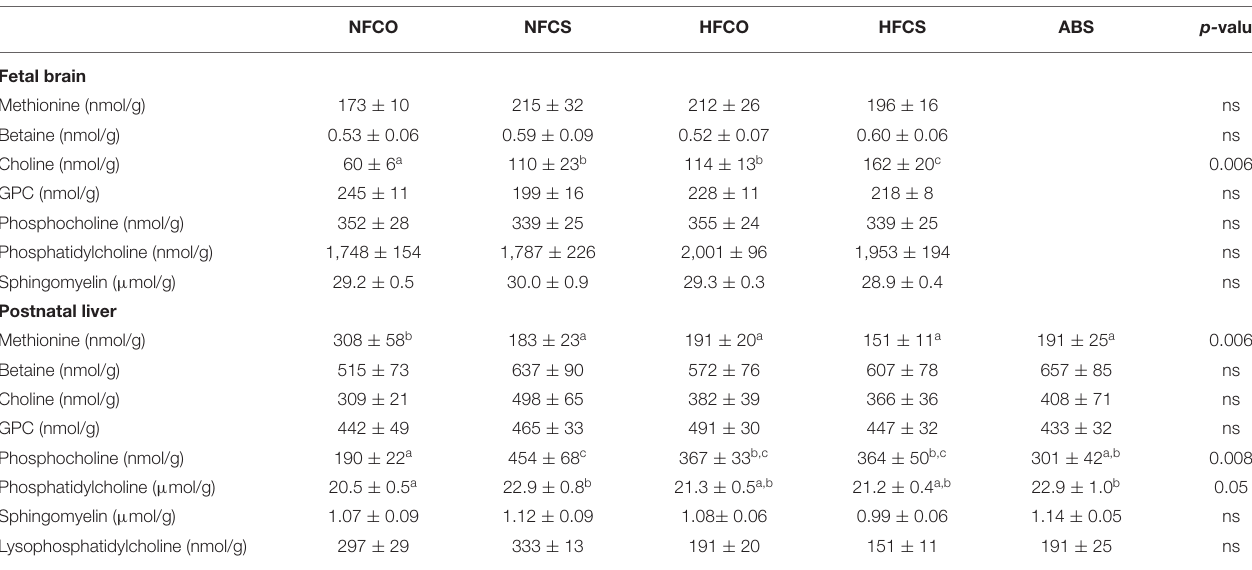
TABLE 2 | Choline metabolite levels in fetal and postnatal tissues. NFCO